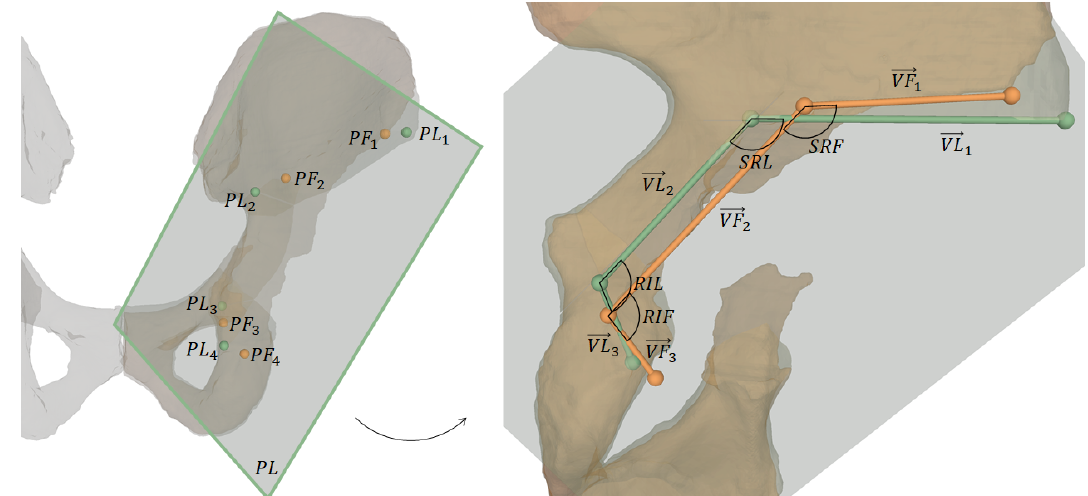
Figure 7. Visualization of outcome measures. The left image shows 3D osteotomy starting points and the projection plane for 2D measurements, which are shown on the right: projected osteotomy starting points, their connecting vectors and the angles between supra- and retroacetabular osteotomy and between retroacetabular and ischial osteotomy,